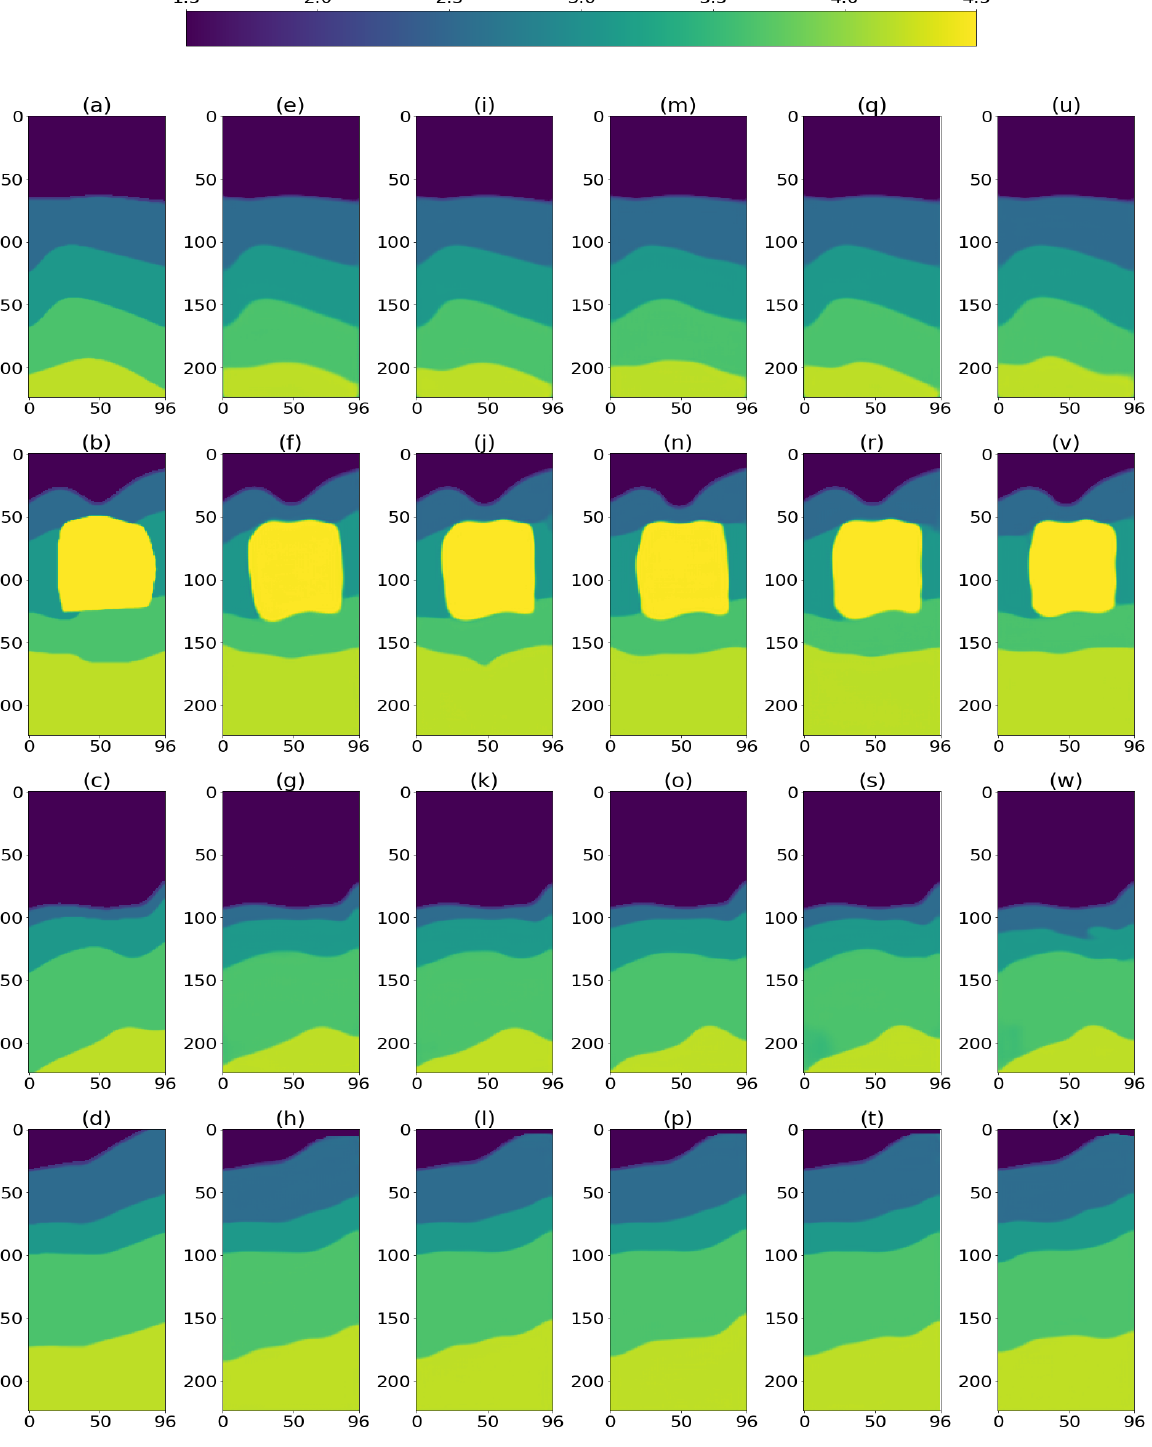
Figure 5. 2D cross-sections of reconstructed 3D models from unseen data: ( a – d ) ground truth. ( e – h ) re- construction from noiseless data. ( i – l ) reconstruction from noisy data: white noise, SNR = 20 dB; and ( m – p ) white noise, SNR = 10 dB. ( q – t ) reconstruction from noisy data: field noise, SNR = 20 dB; and ( u – x ) field noise, SNR = 10